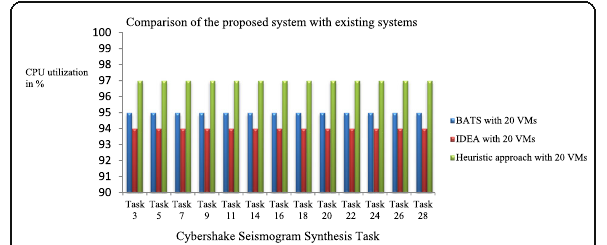
Fig. 10 CPU utilization by Cybershake tasks